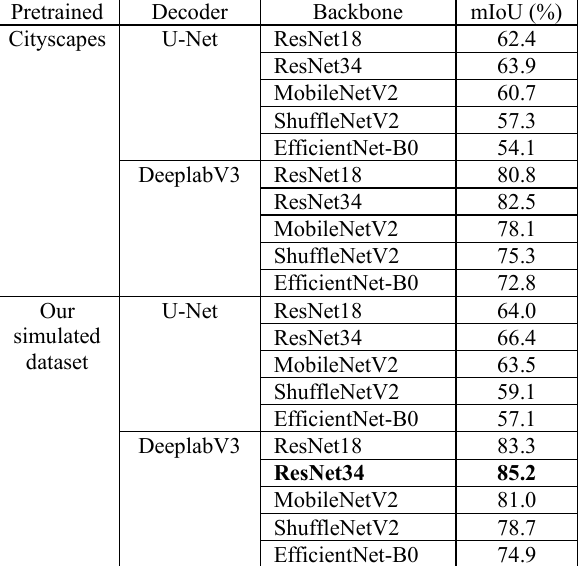
Table 5. Our off-road validation set results.